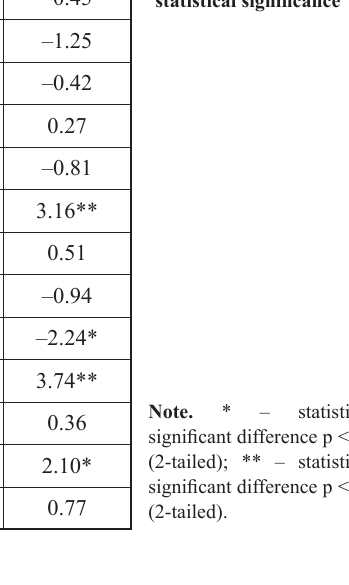
Table 2. Main results of hierarchical regression analysis: t values